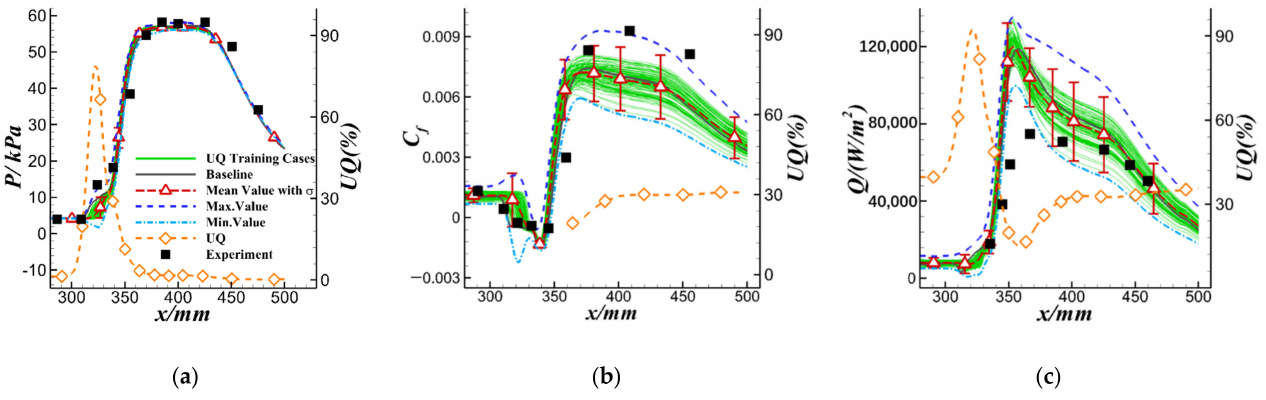
Figure 10. Distributions of the wall properties with uncertainty analysis results for θ = 14 ◦ case.